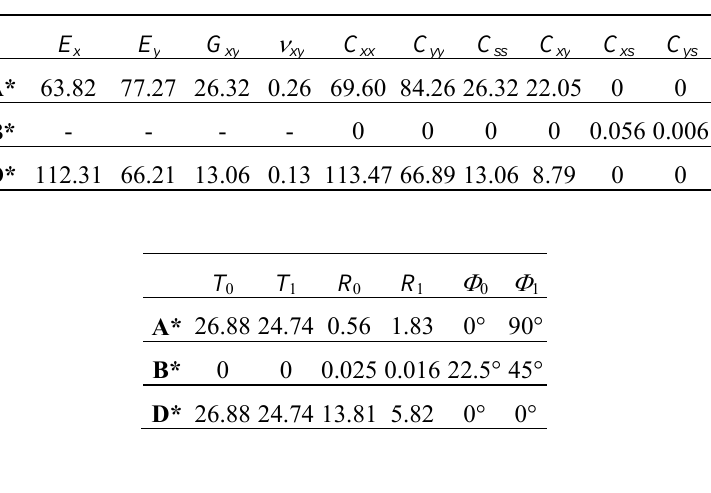
Table 6. Example 3: technical, Cartesian and polar constants of the best solution laminate; C is a generic Cartesian component ij